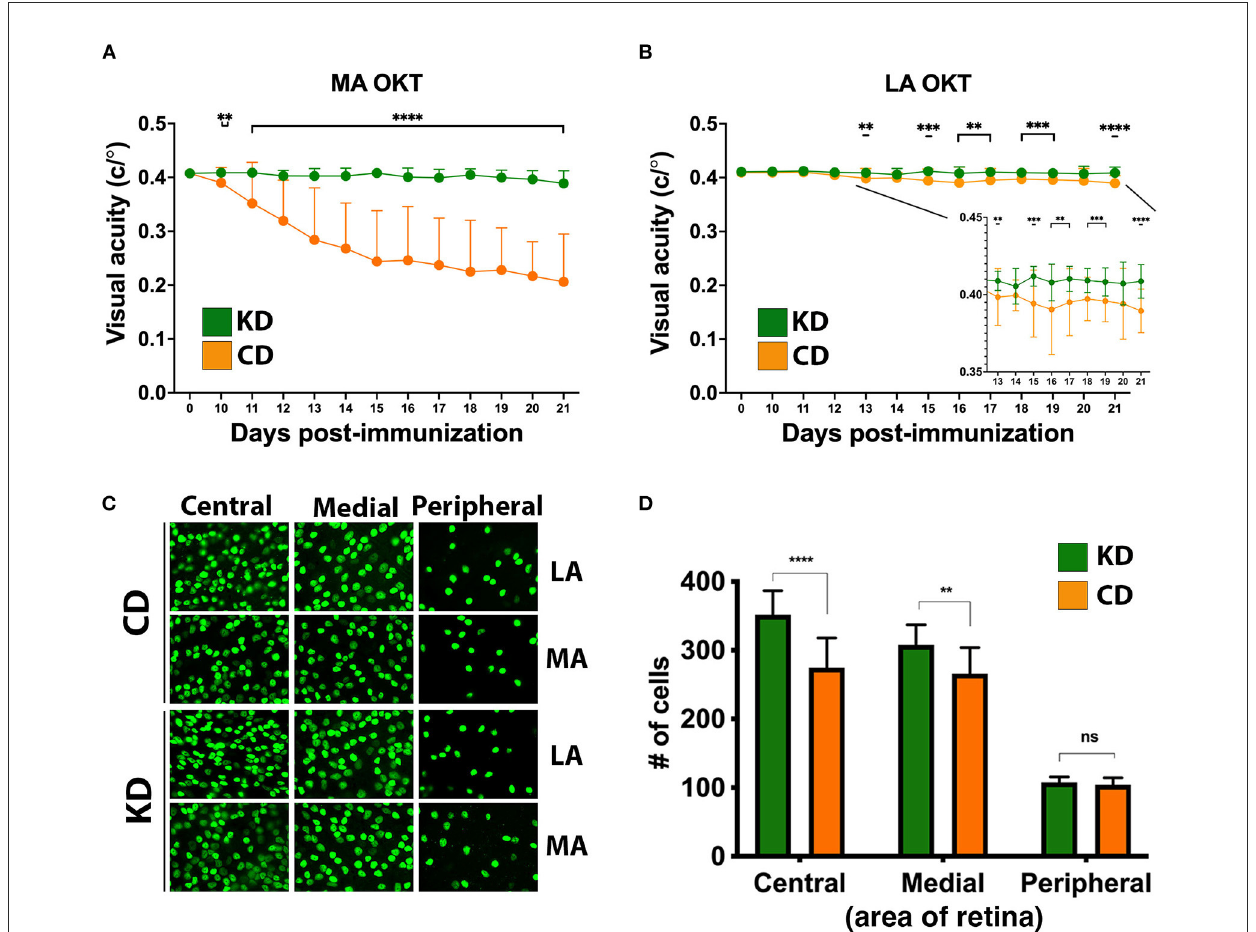
FIGURE3 The KD prevents visual acuity deficits and spares retinal ganglion cells in the central retinas of EAE mice. (A) OKT measurements of visual acuity of the more affected (MA) eyes of EAE mice fed the KD (green) or CD (orange); n = 14–17 mice/diet. (B) Same as (A) for less affected (LA) eyes; n = 10–12 mice/diet. Inset with adjusted scales of x -axis and y -axis highlights significant differences in visual acuity between diets. Whisker-bar standard deviations and p -values for differences between curves in (A, B) were computed with mixed linear model implementation of lme function, nlme R package. (C) Representative photomicrographs of Brn3A + RGCs in the central, medial, and peripheral retinas of mice as a function of diet. Examples are shown for both the MA and the LA eyes. (D) Graph of Brn3A + RGC cell counts in central, medial, and peripheral retinas of MA eyes as a function of diet. Data are color coded based on diet as in (A, B) . Data compiled ≥ 4 independent experiments. ** p < 0.01, *** p < 0.001, **** p < 0.0001; ns, not